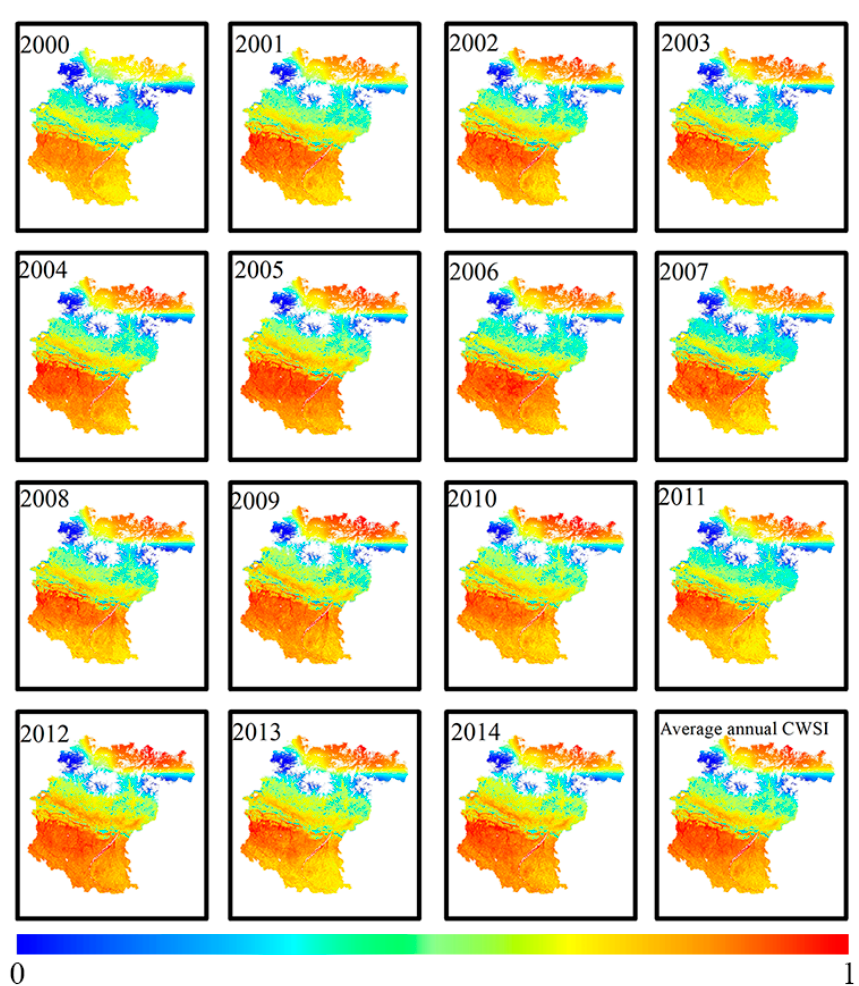
Figure 2. Spatial distribution of Drought degree in Koshi River Basin (KRB) in different years.